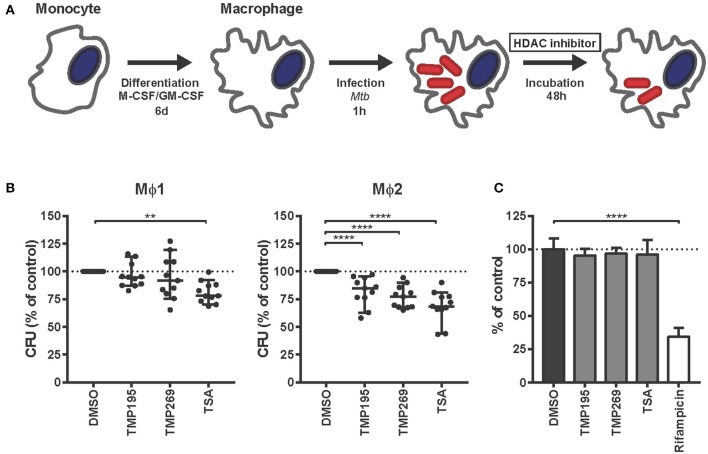
HDAC inhibitors decrease Mtb survival in human macrophages in a host-directed manner. (A) Schematic outline of the experimental setup used in (B). (B) Mϕ1 and Mϕ2 macrophages derived from 11 different donors were infected with Mtb for 1 h at MOI 10 and treated with TMP195 (10 μM), TMP269 (10 μM), TSA (100 nM), or DMSO at equal v/v for 48 h post-infection. Dots represent the mean of 3 CFU assay replicates of a single donor expressed as a percentage of the DMSO control. Horizontal lines indicate median CFU values of all 11 donors and whiskers represent 95% confidence intervals. Statistically significant differences compared to DMSO were tested using a RM one-way ANOVA (**p < 0.01, ****p < 0.0001). (C) Thirteen days treatment of a Mtb broth culture in the presence of 10 μM TMP195, TMP269, or TSA. Rifampicin (20 μg/ml) was used as a positive control. Bars depict the mean bacterial density at 550 nm ± standard deviation of six replicates from a representative experiment out of two independent experiments. The bacterial load is expressed as a percentage of the DMSO control value. Statistically significant difference compared to DMSO was tested using a one-way ANOVA with Dunnett's multiple test correction (****p < 0.0001).